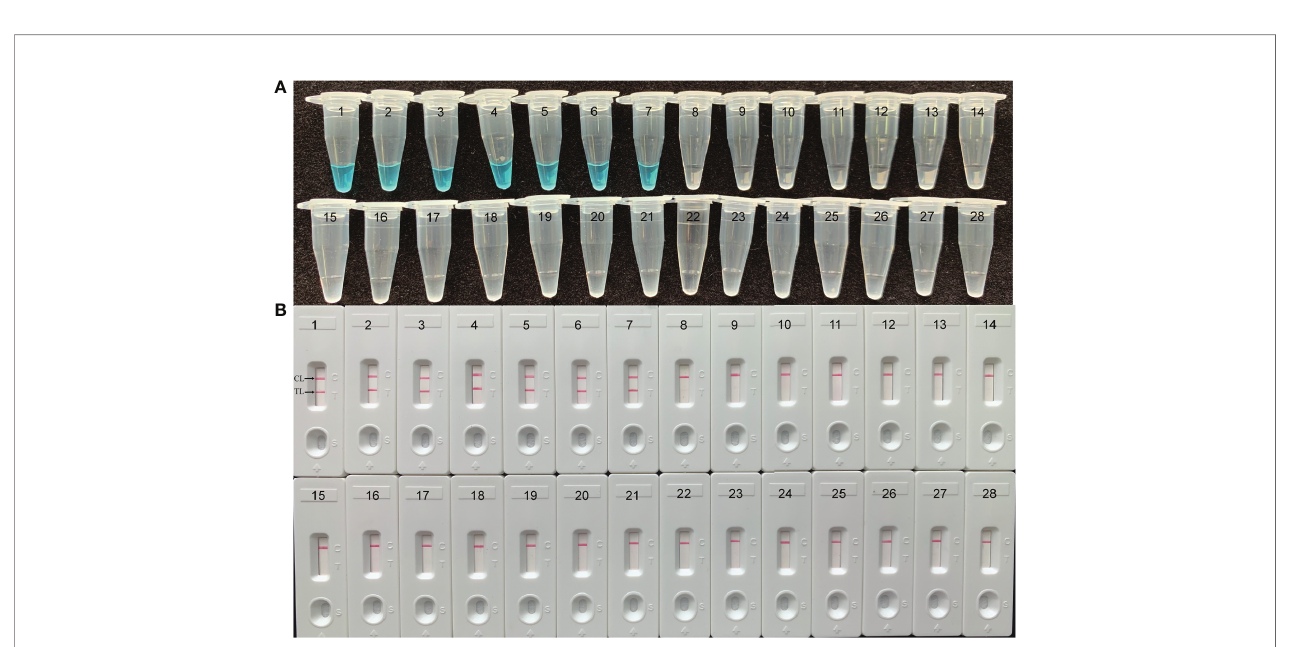
FIGURE 5 | Speci fi city of H . in fl uenzae -MCDA-LFB assay with DNA templates from distinct strains. The MCDA reactions were conducted with different genomic DNA templates and were analyzed by means of visual mode including VDR (A) and later fl ow biosensor (B) . 1 – 7, H . in fl uenzae strains; 8 – 9, H . parain fl uenzae ; 10, H . haemolyticus ; 11, H. parahaemolyticus ; 12, Enteroadhesive E . coli ;13, Enterohemorrhagic E . coli ; 14, Enteropathogenic E . coli ; 15, Enteroinvasive E . coli ; 16, Enterotoxigenic E . coli ; 17 – 18, Listeria monocytogenes ; 19 – 20, Pseudomonas aeruginosa ; 21, Streptococcus suis ; 22 – 23, Klebsiella pneumoniae ; 24, Staphylococcus aureus ; 25, Staphylococcus epidermidis ; 26, Staphylococcus haemolyticus ; 27, Acinetobacter baumannii ; 28, Enterococcus faecalis .